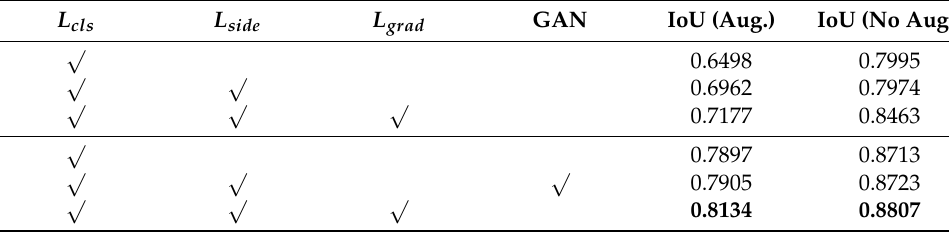
Table 4. Performance comparison of different loss